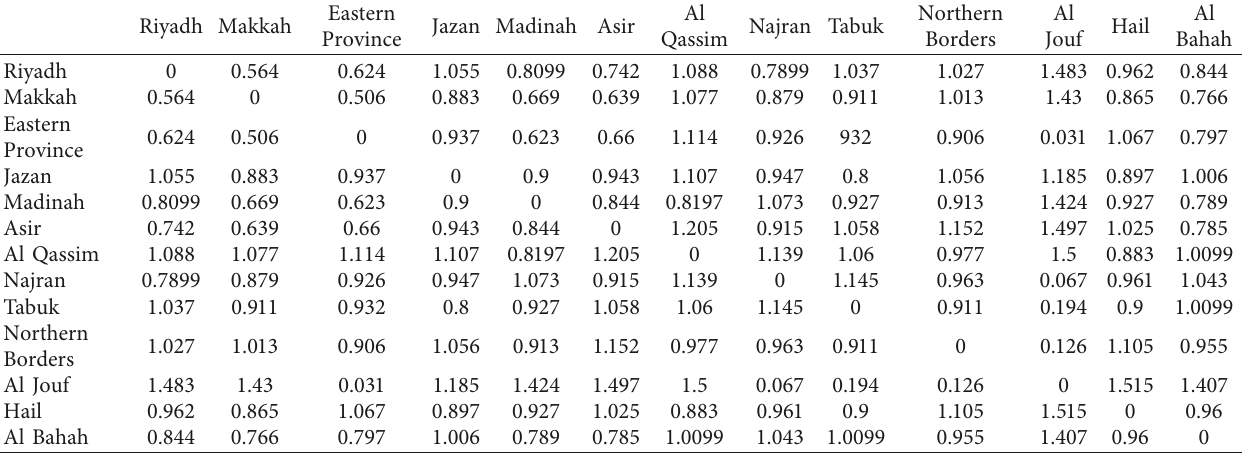
Table 4: Distance between different cities based on equation (3).